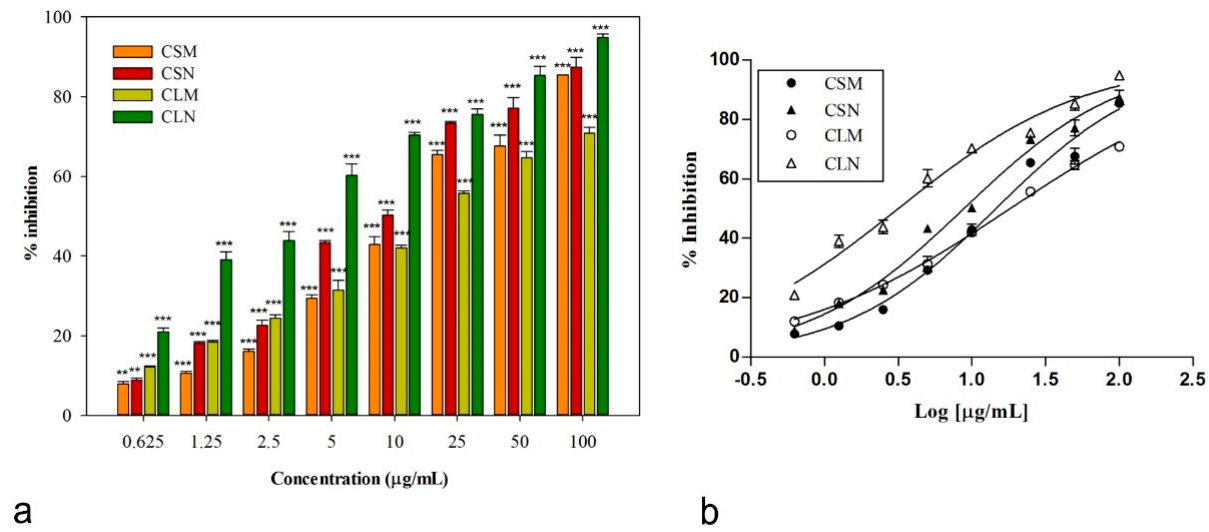
Figure 2. ( a ) Concentration-dependent photocytotoxic effects induced by Cachrys samples. Cells were irradiated for 1 h at a dose of 1.08 J/cm 2 ; ( b ) non-linear regression analyses: CSM, C. sicula L. maceration; CSN, C. sicula L. Naviglio extractor ® ; CLM, C. libanotis L. maceration, CLN, C. libanotis L. Naviglio extractor ® . Data were expressed as means ± SEM ( n = 4). *** p < 0.001, ** p < 0.01 (Dunnett’s test) compared to control (untreated irradiated cells). Table 4. Photocytotoxicity of Cachrys libanotis L. and Cachrys sicula L. extracts on C32 cells. IC 50 ( µ g/mL) Species Extract Irradiated Cells Unirradiated Cells Cachrys sicula L. CSM 14.57 ± 0.95 c >100 CSN 8.83 ± 0.20 b 26.72 ± 1.18 d Cachrys libanotis L. CLM 18.18 ± 1.33 c >100 CLN 3.16 ± 0.21 a 55.20 ± 1.65 e Bergapten 1 0.191 ± 0.012 a n.d.